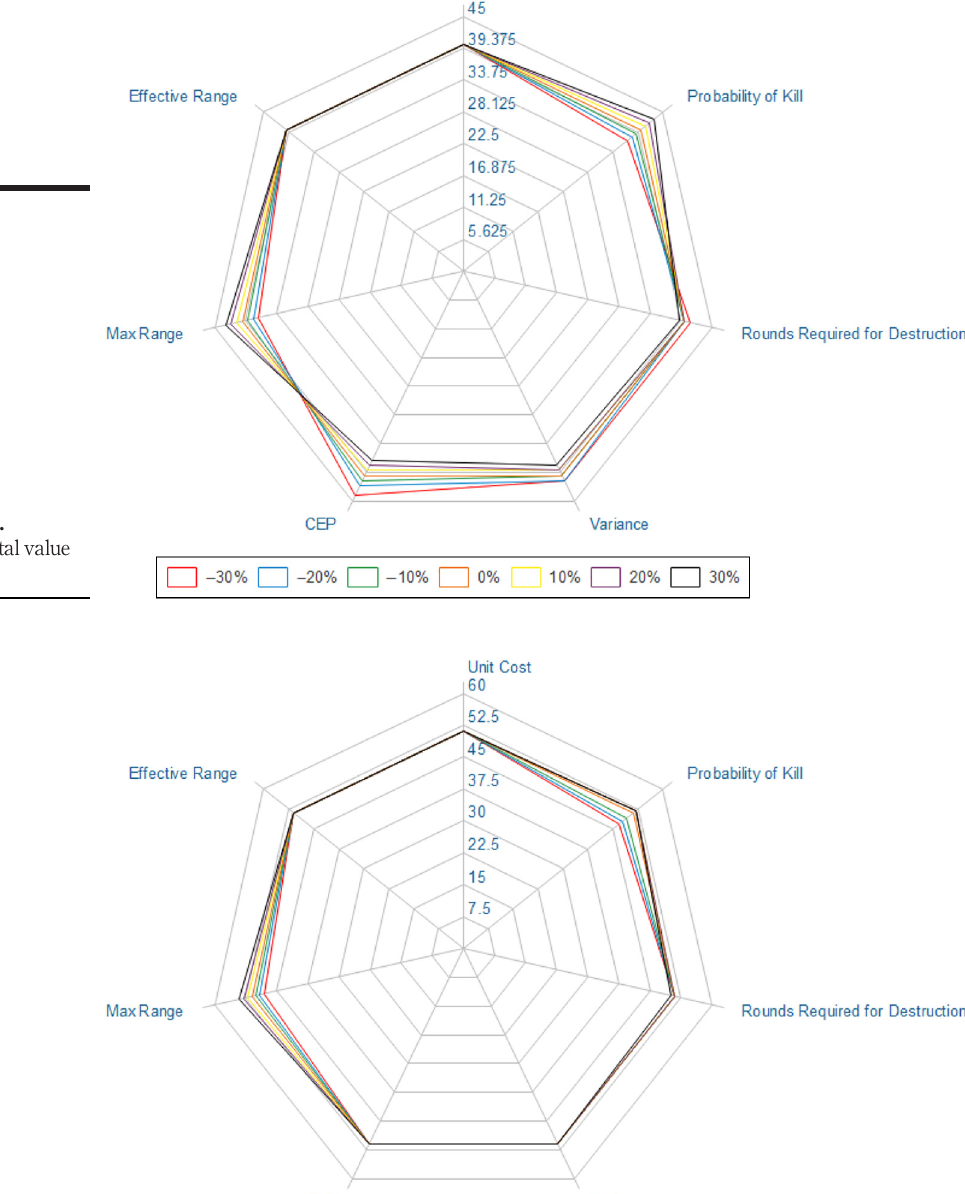
Figure 14. M982 1a-1 total value